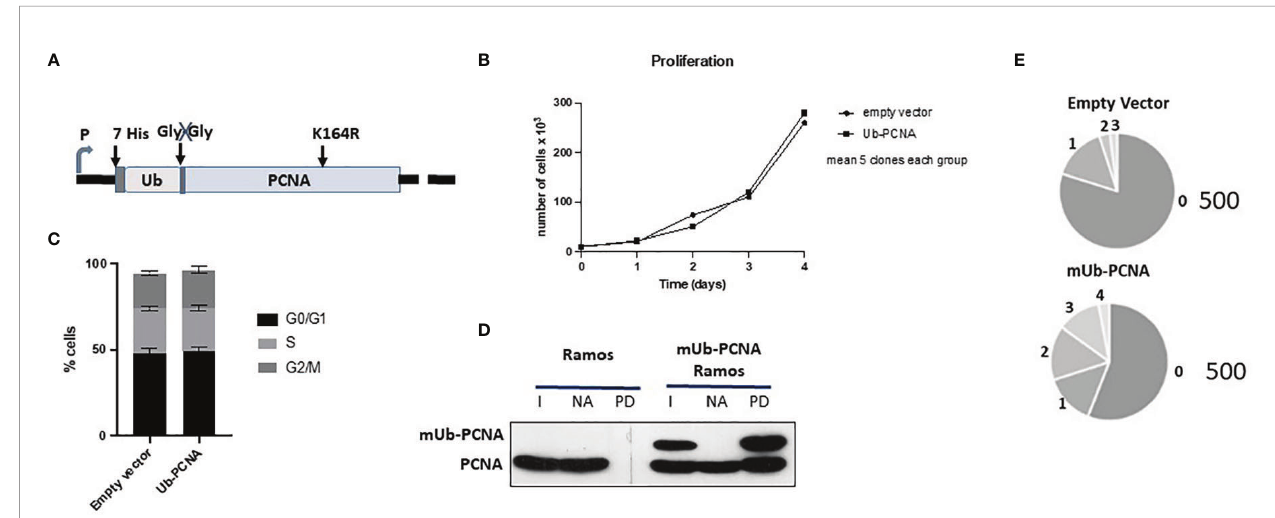
FIGURE 4 | Schematic diagram of the mUb-PCNA fusion construct and validation in Ramos cells. (A) Schematic diagram of the mUb-PCNA fusion construct used. (B) Cell proliferation analysis. Cell growth was estimated by counting the viable cells on the indicated days. (C) Cell cycle analysis by DNA content estimation with fl ow cytometry and represented as histograms showing the relative percentage of cells at the indicated phases of the cell cycle. The data in B and C represent the mean of three independent experiments. (D) His7-UbPCNA was pulled down with nickel beads, and the fraction pulled down was analyzed by SDS – PAGE and immunoblotting using an anti-PCNA antibody. I, input; NA nonadsorbed, PD pull down. (E) Sequence analysis of SHM in the ampli fi ed Ramos VH region. The pie segments represent the proportion of clones that contained the speci fi ed number of mutations (from 0 to 4) indicated. The total number of analyzed sequences is indicated in the right of each chart and corresponds to the pool of the data obtained from the fi ve clones reported in Table 2A